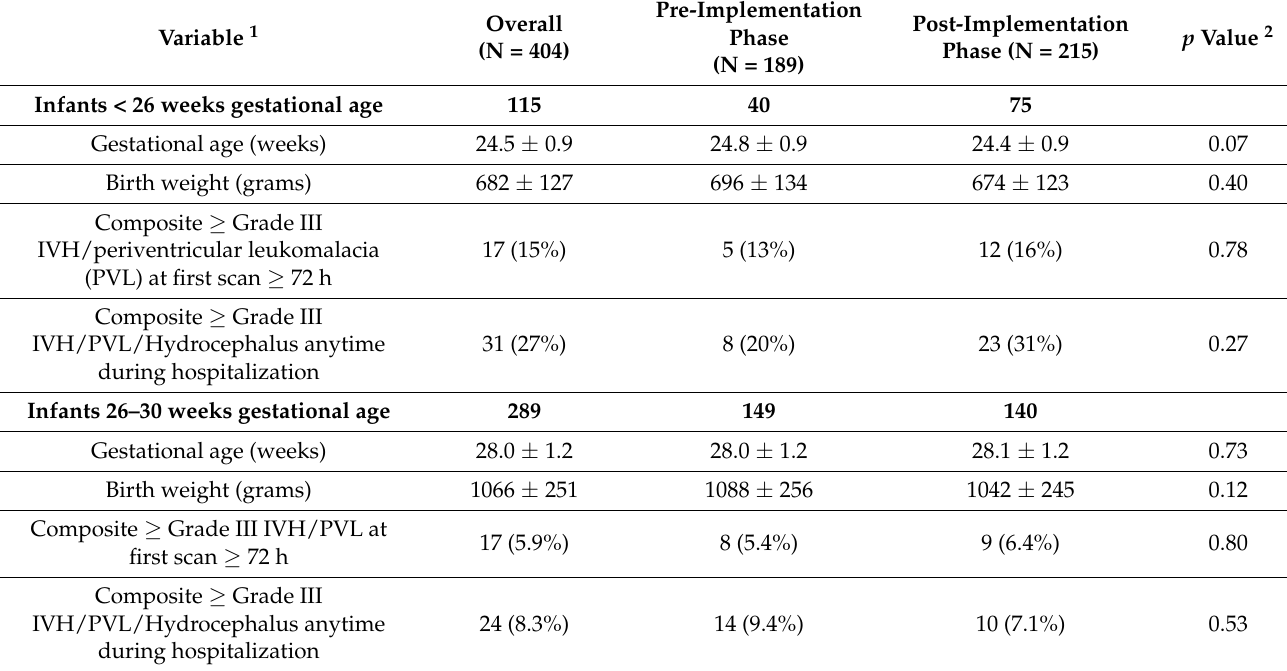
Table 4. Incidence of ≥ grade III intraventricular hemorrhage (IVH) based on gestational